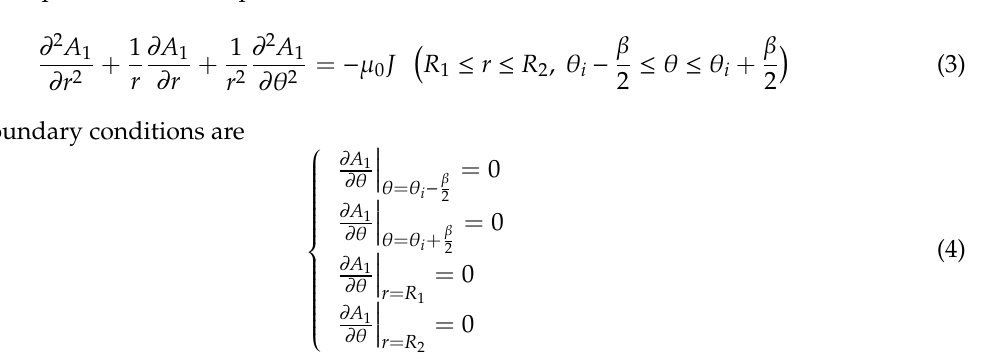
Figure 2. Current density distribution of double-layer winding in the slot.